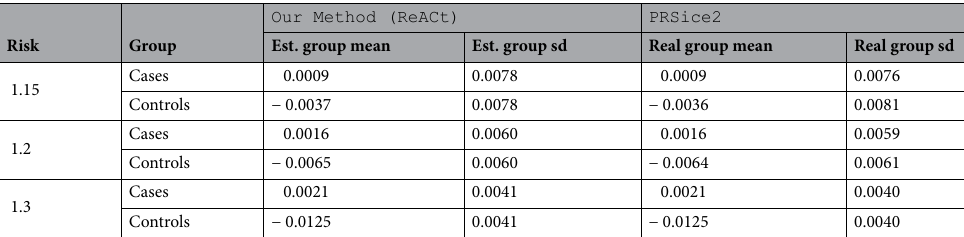
Table 5. Estimated and real group mean and standard deviation of PRS for a synthetic target population. We compared group mean and standard deviation of PRS estimated by ReACt from summary statistics of synthetic base and target studies to the real group mean and standard deviation of individual level PRS obtained using summary statistics of the base and individual level genotype of the target computed by PRSice2. Est stands for estimated. Note that the synthetic data is not subject to clumping since the simulation model does not generate LD structure.